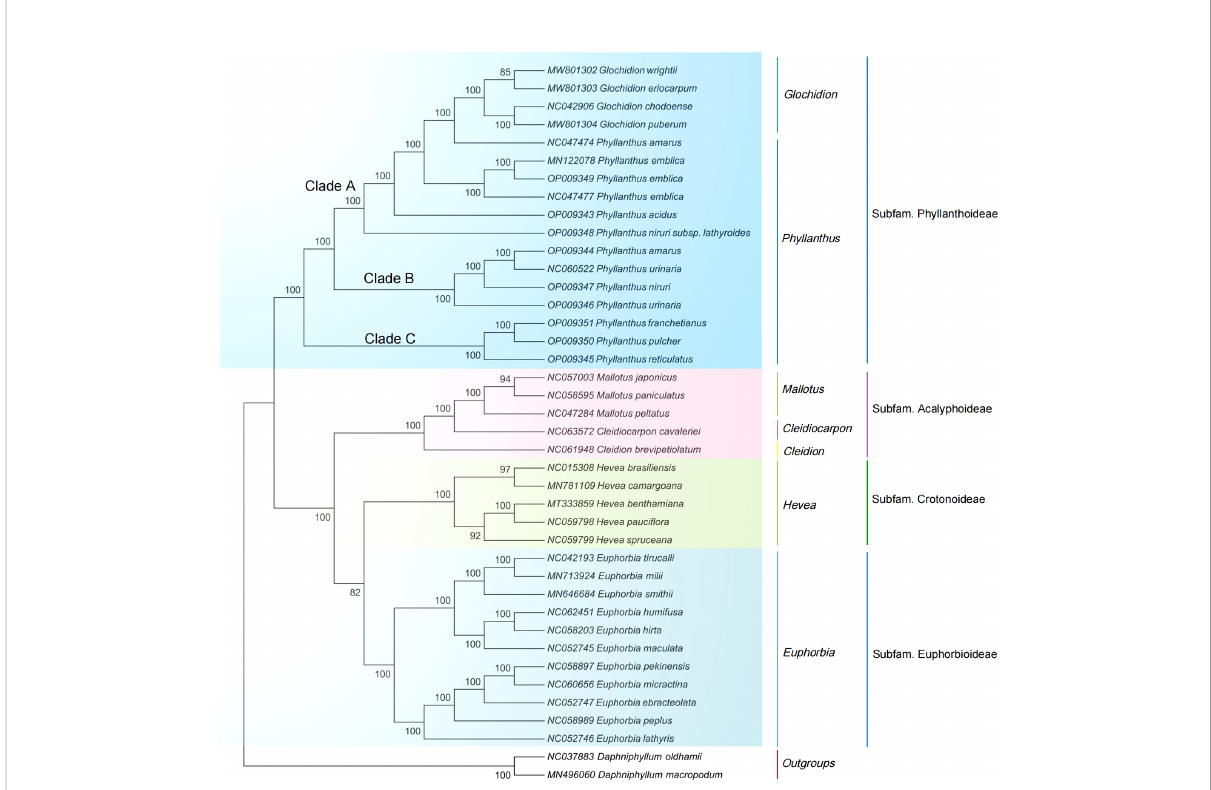
FIGURE 5 Maximum likelihood phylogenetic tree based on complete cp genomes. Daphniphyllum oldhamii and D. macropodum were used as outgroups. Numbers at nodes are bootstrap support